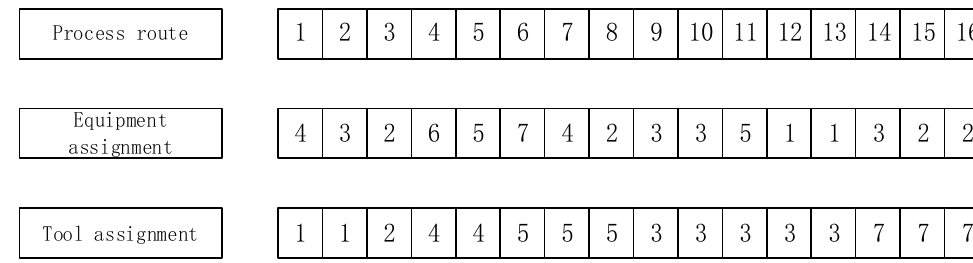
Figure 4. Individual coding method.